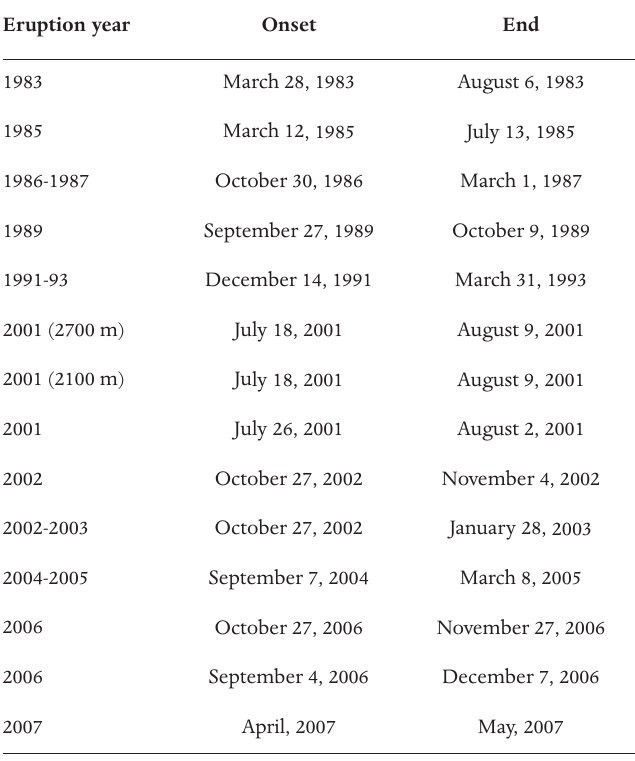
Table 3. Eruptions that occurred after 1981, as used for the validation.